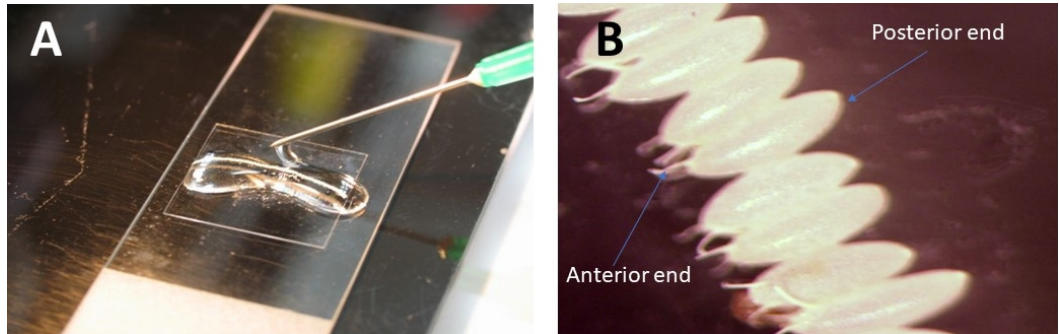
Figure 4. ( A ) Adding the halocarbon oil mixture to a line of eggs. ( B ) The anterior ends of the eggs contain the filaments (left), while the posterior ends point to the right.